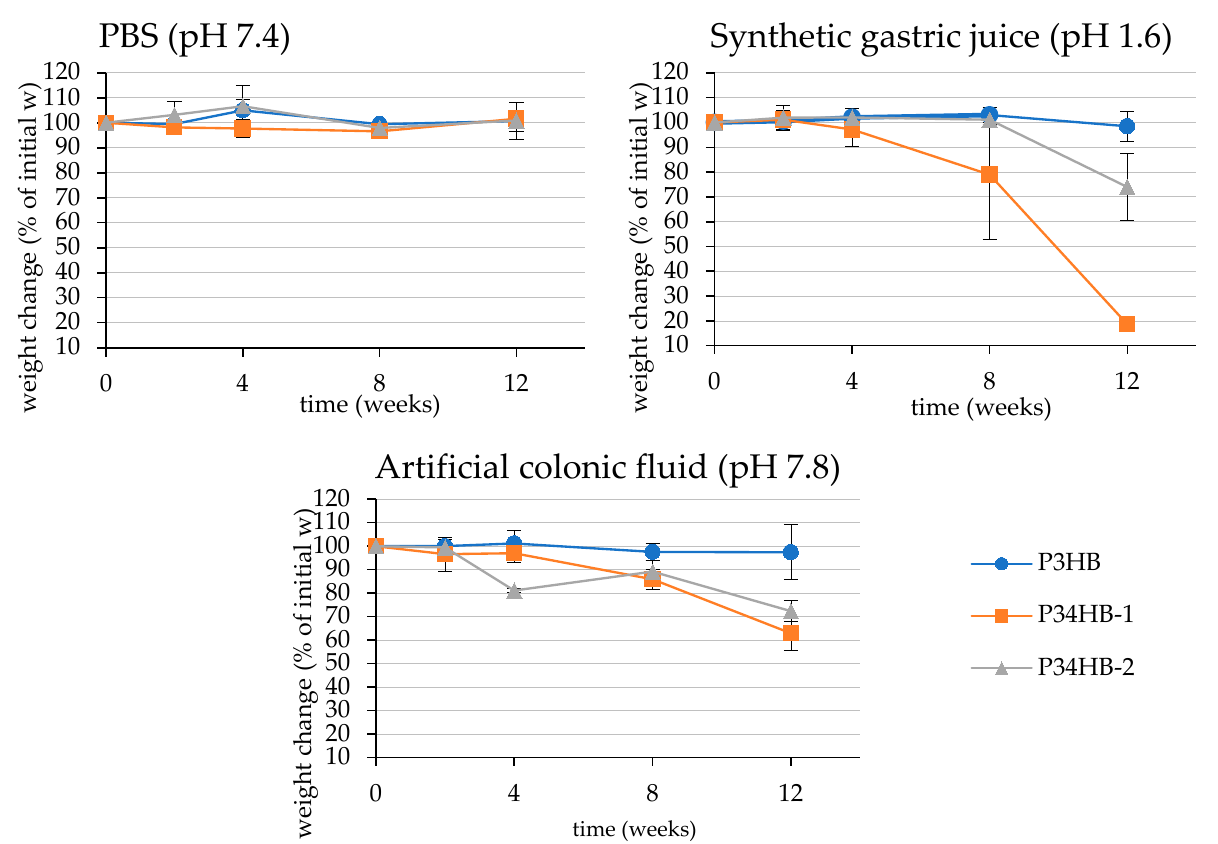
Figure 2. Weight changes of films during incubation in PBS, synthetic gastric juice, and artificial colonic fluid, expressed as relative weight change in %. Table 2. Changes in molecular weight expressed as percentual weight of initial M W